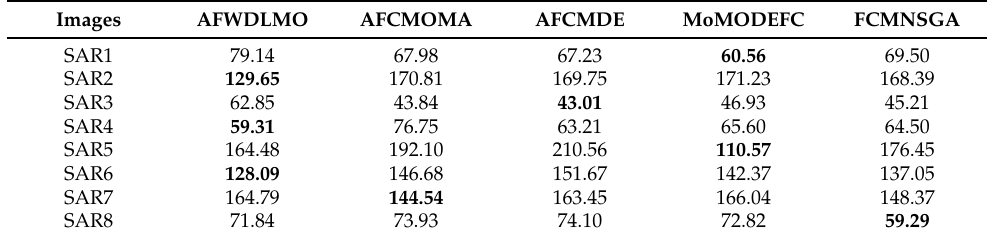
Table 5. Average time consumption of each algorithm for SAR